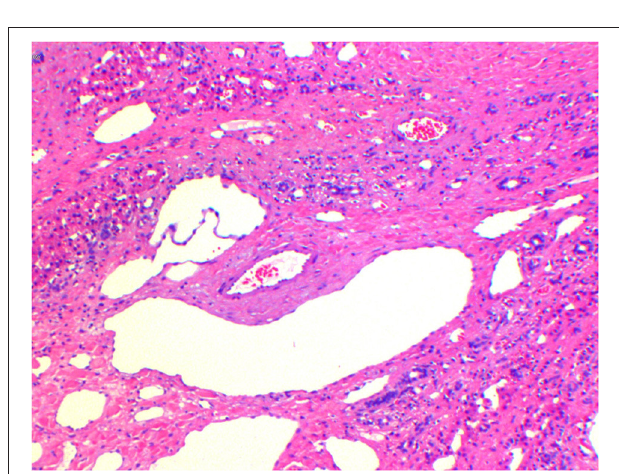
FIGURE 4 | Pathological HE staining. The tumor consists of abnormally dilated multicystic-like lymphatic vessels and blood vessels, in which hepatocytes and small bile ducts were